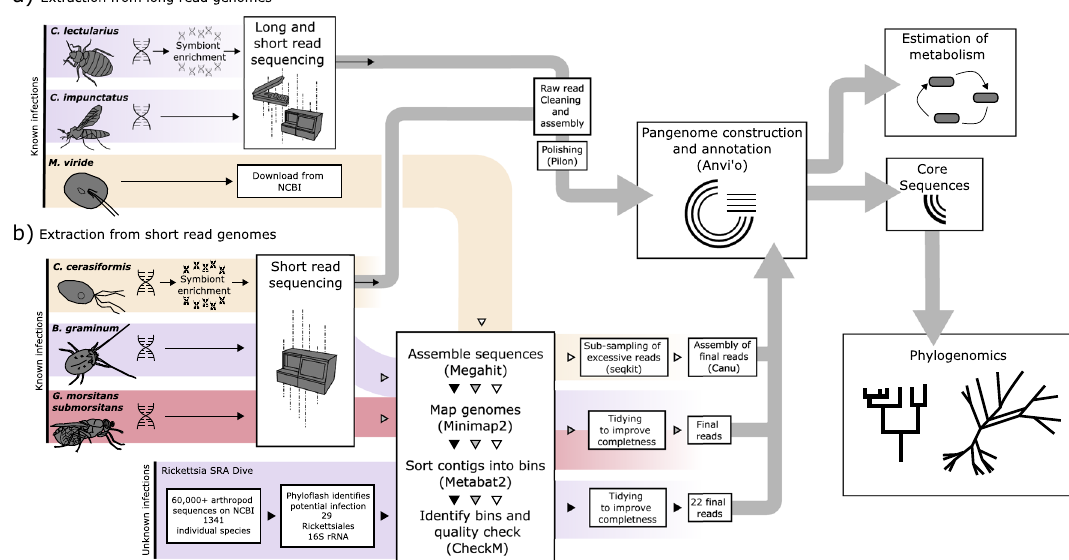
Fig. 6 Work fl ow diagram for extraction, assembly and analyses performed in this study. Work fl ows for genome assemble are illustrated for ( a ) long read host insect sequences and ( b ) short read host insect sequences. Purple highlights Torix Rickettsia and orange highlights ‘ Ca . Megaira ’ and red highlights Transitional Rickettsia . Sequencing technologies used vary with source and include Illumina short read sequencing, BGI DNBseq, Oxford Nanopore and